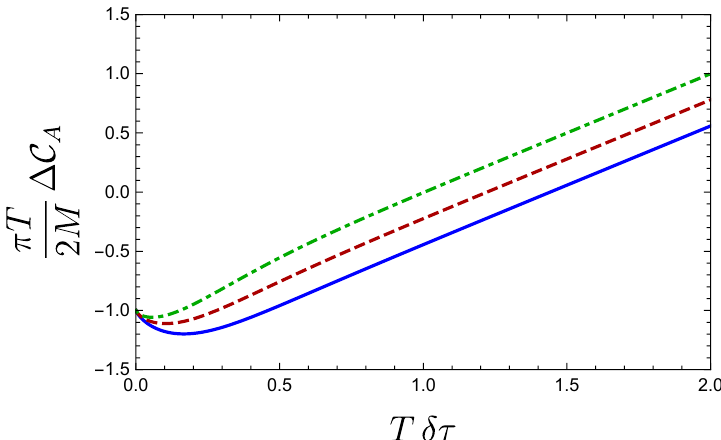
for R= ~ L = 0 : 5 (solid blue), R= ~ L = 1 : 0 (dashed 2 (cid:25)